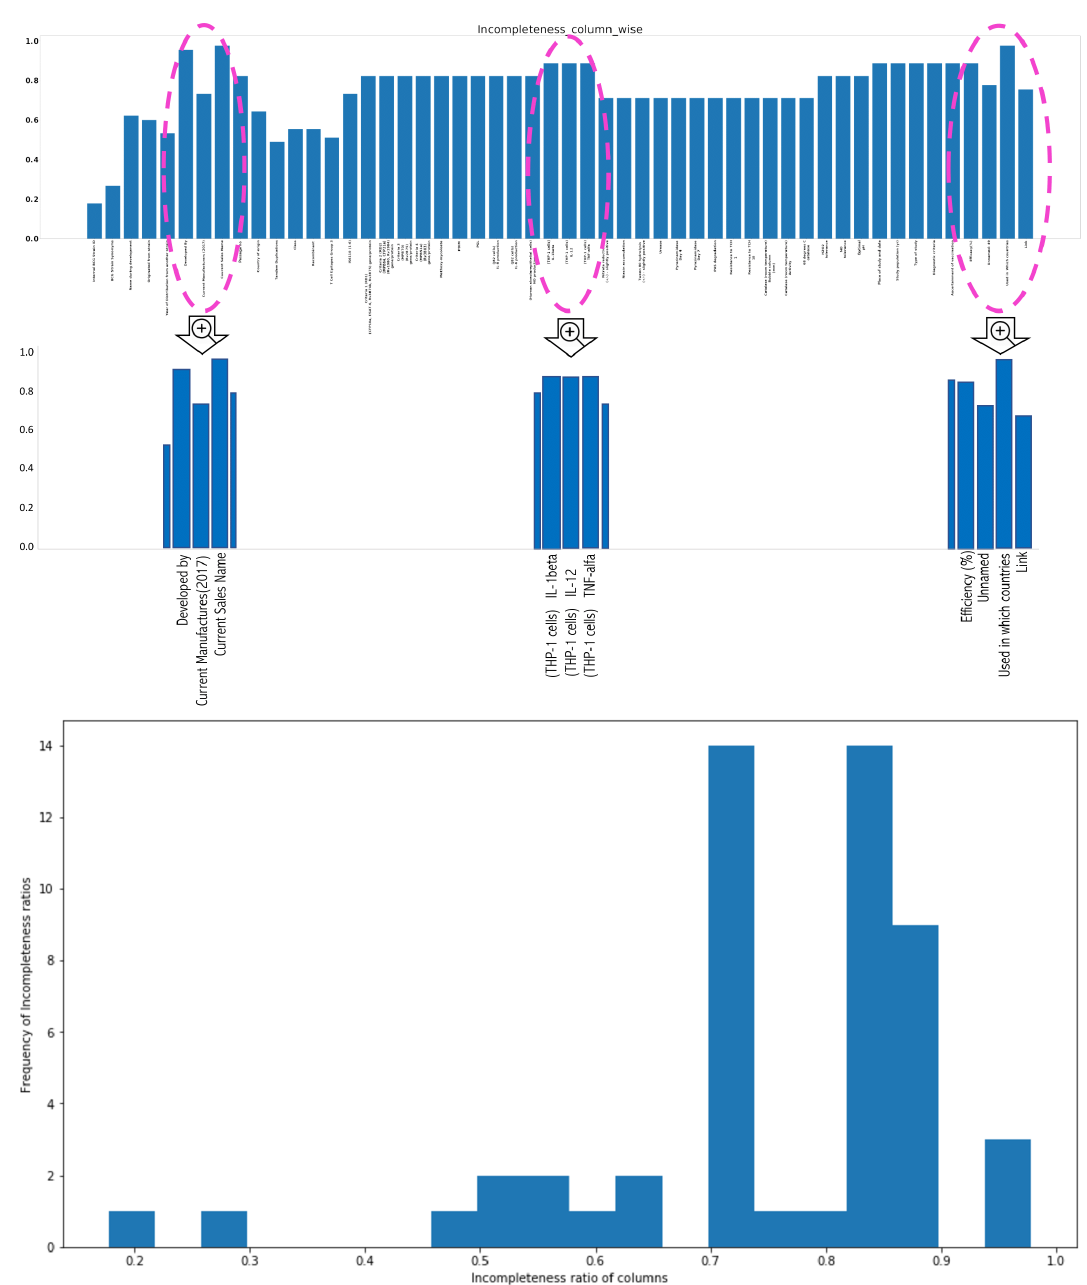
Figure 2. RIS of each column and histogram of BCG Strains